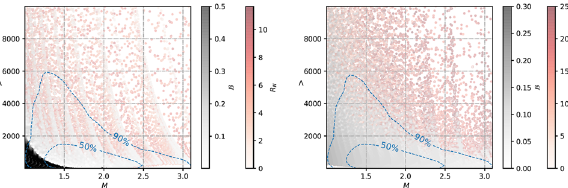
Fig. 13 Density plots of parameters ( B , r W ) on the ( M ,Λ) -plane of the hybrid star configurations of scenario I (Left panel, with r W = R N ) and II (Right panel, with r W = R D ), with neutron EoS chosen as SLy4. The sidebars indicate the scales of the density plots. There is no hybrid star configuration falling inside the corresponding ( M ,Λ) regions when ( B , r W ) go beyond the maximal values of the sidebars.